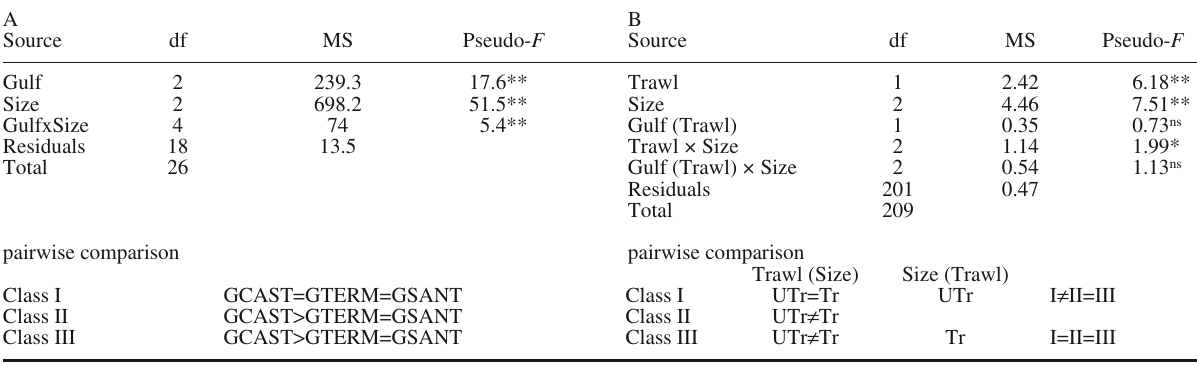
Table 2. – A, results of PERMANOVA performed on density of hake for the two factors Gulf and Size. B, results of PERMANOVA per- formed on N% for each prey item in the three gulfs and in the three size classes. *, P <0.05; **, P <0.01; n.s., not significant; GCAST, Gulf of Castellammare; GTERM, Gulf of Termini Imerese; GSANT, Gulf of Sant’Agata; I, size class I (60-120 mm TL); II, size class II (121-220 mm TL); III, size class III (221-410 mm TL).